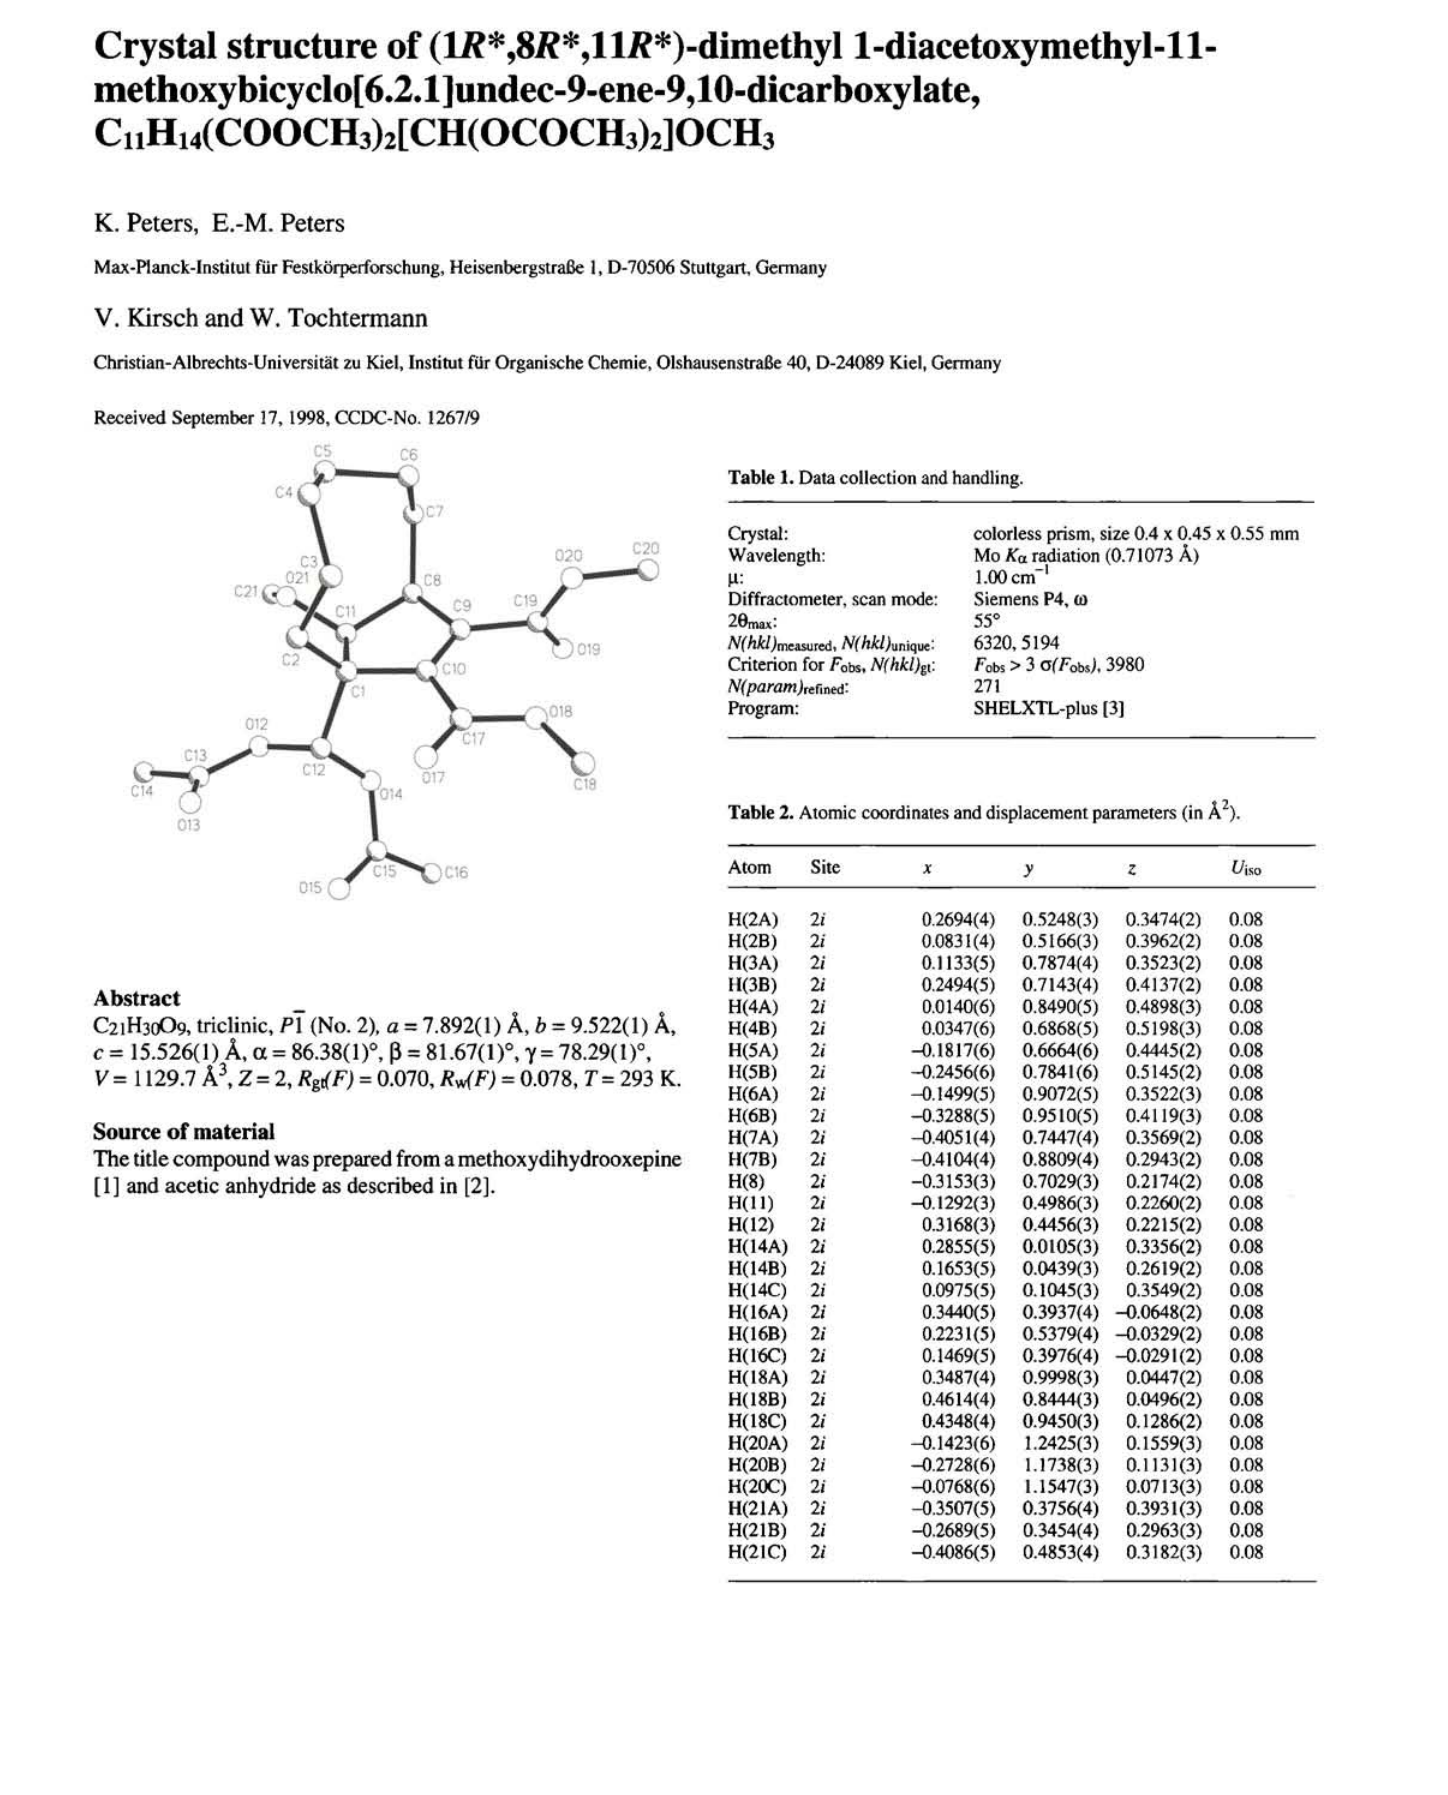
Table 1. Data collection and handling.